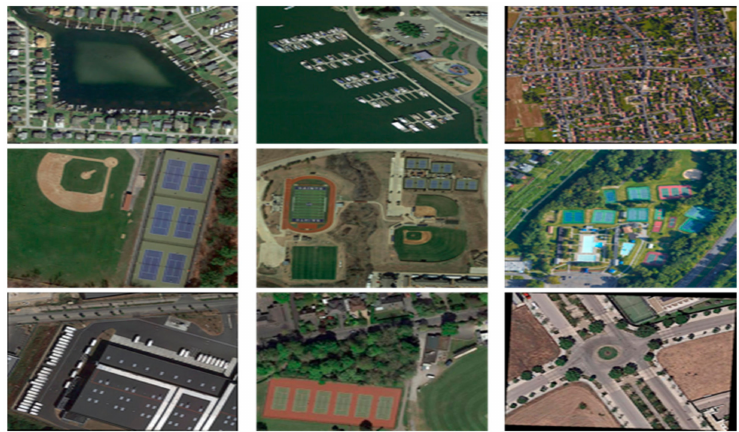
Figure 11. A few class representatives of the NWPU-RESISC45 dataset.